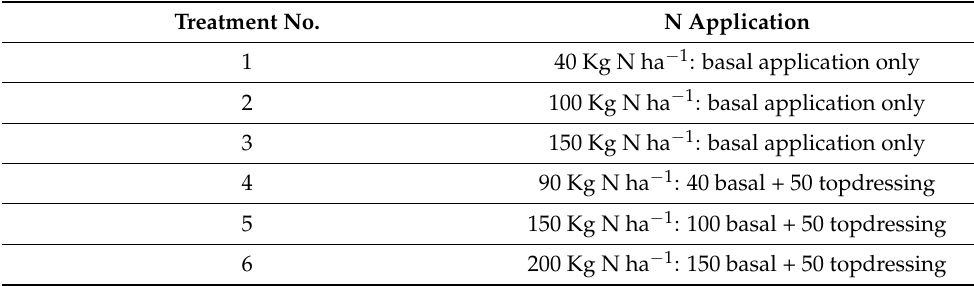
Table 2. Nitrogen application treatments (kg pure N ha − 1 ) in the field experiment. Treatment